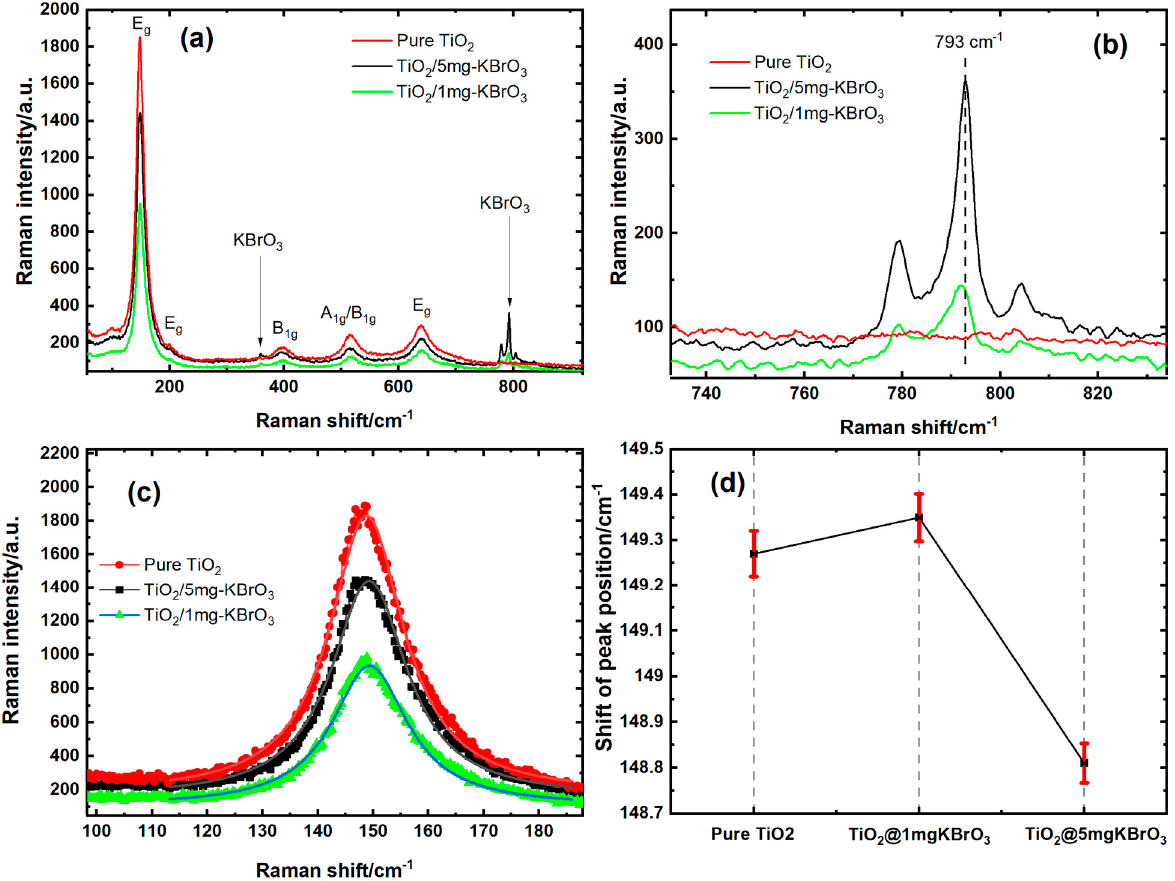
Figure 4. ( a ) Room-temperature Raman spectra of pure TiO 2 , TiO 2 /1 mg-KBrO 3 , and TiO 2 /5 mg- KBrO 3 ( b ) zoom in the spectral range of KBrO 3 vibrational modes. ( c ) Fitting of the E g mode with a Lorentzian function of Pure TiO 2 , TiO 2 /1 mg-KBrO 3 , and TiO 2 /5 mg-KBrO 3 . ( d ) Variation of the E g mode position versus the KBrO 3 mass fraction.